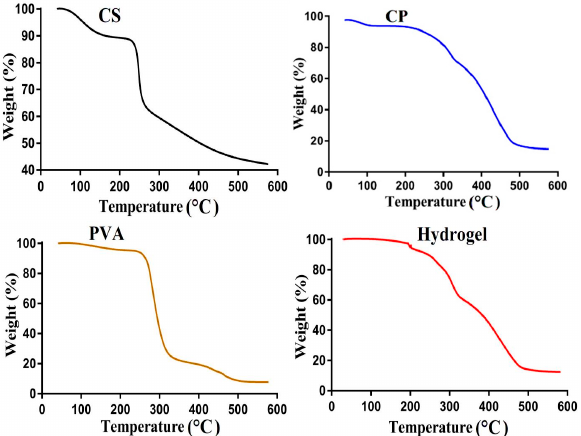
Figure 4. TGA of CS, CP, PVA, and CS/CP/PVAcPAa hydrogel.